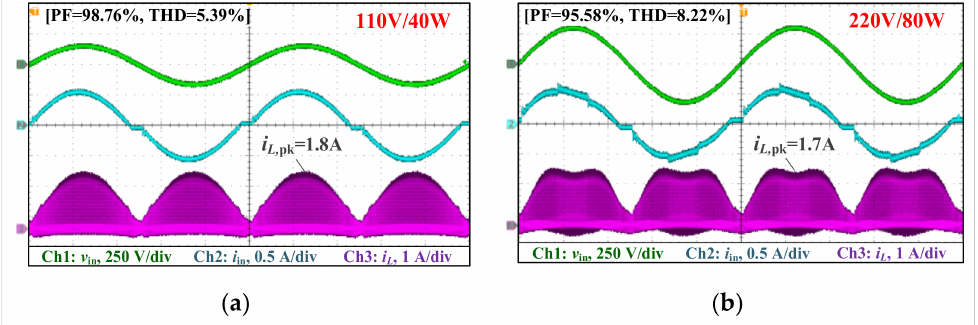
Figure 13. Waveforms at low power. ( a ) 110 V/40 W; ( b ) 220 V/80